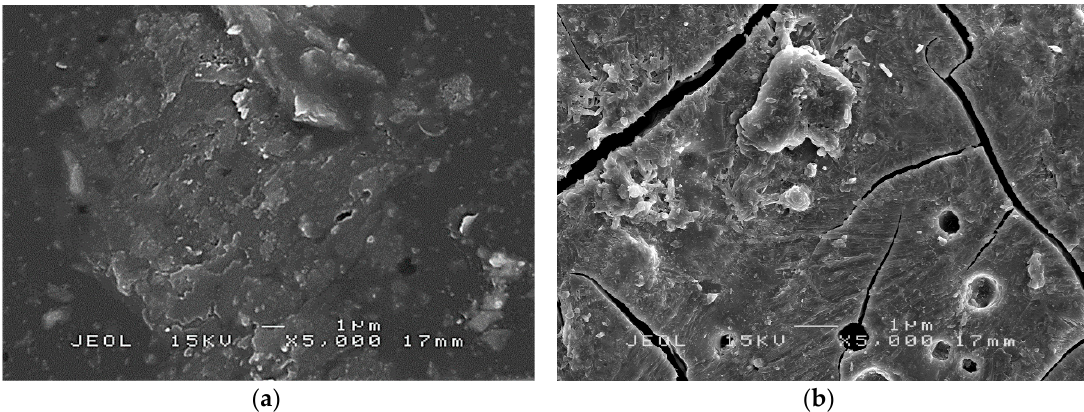
Figure 14. Particle agglomeration of RHA-based geopolymer following flexural test: ( a ) S13; and ( b ) S17 for the flexural test.